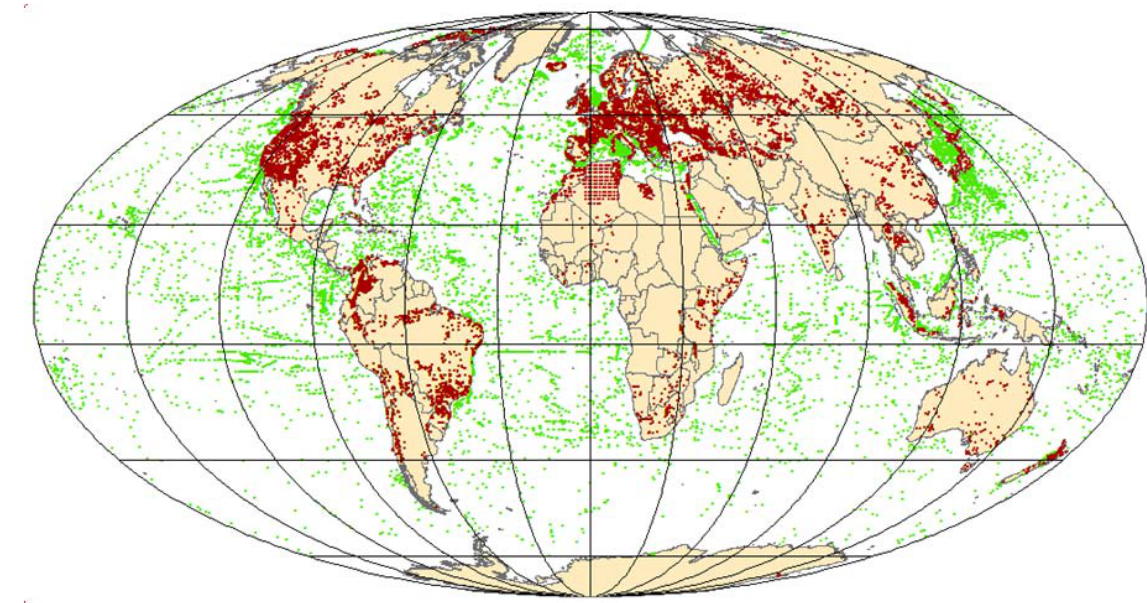
Fig. 1. Geographic distribution of heat flow measurements, as per the updated data base reported by Vieira and Hamza